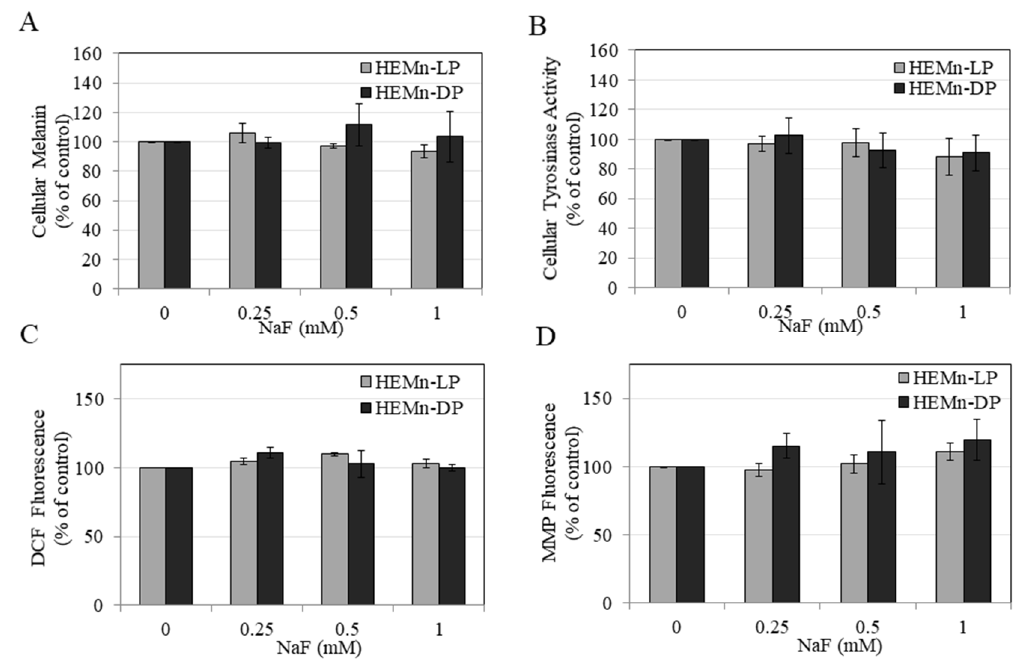
Figure 3. Effects of 72 h treatment with NaF in HEMn-DP and HEMn-LP cells on ( A ) melanin production levels, ( B ) cellular tyrosinase activity, ( C ) cellular reactive oxygen species (ROS) generation, and ( D ) cellular mitochondrial membrane potential (MMP) levels. One-way ANOVA with Tukey’s test, p > 0.05 for all groups. All data are mean ± SEM of at least two independent experiments ( n = 2).